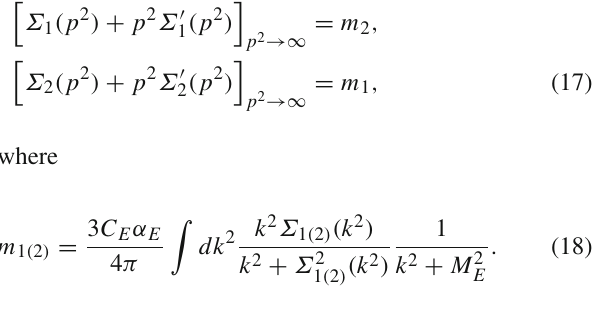
The blue curve ( (cid:2) ) corresponds to the result obtained in [40], while the red curve ( Δ ) is the numerical one obtained with Eqs. (11)–(13). The dot-dash lines represent the